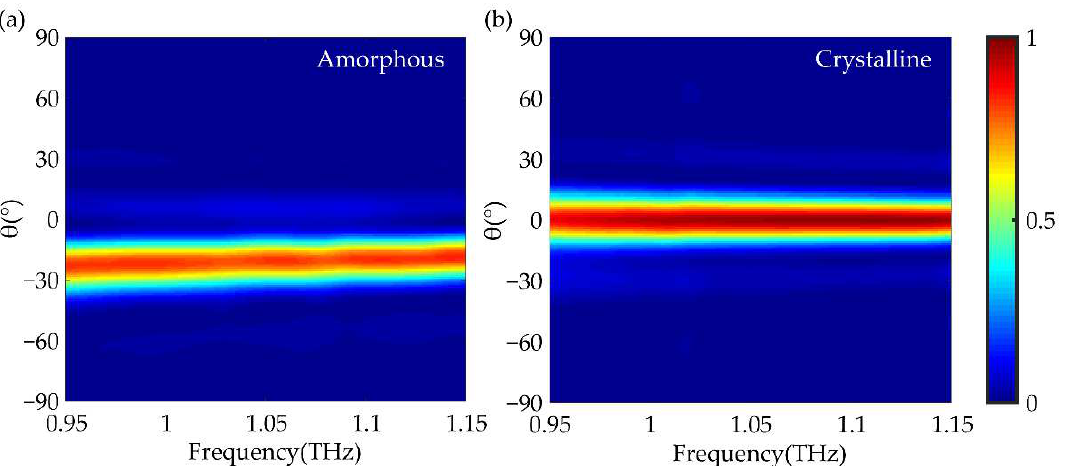
Figure 7. Normalized far-field radiation patterns of anomalous beam deflector when incidence light frequencies in 0.95~1.15 THz. The deflection angle and reflection intensity of the device in GST amorphous state ( a ) and crystalline state ( b ).